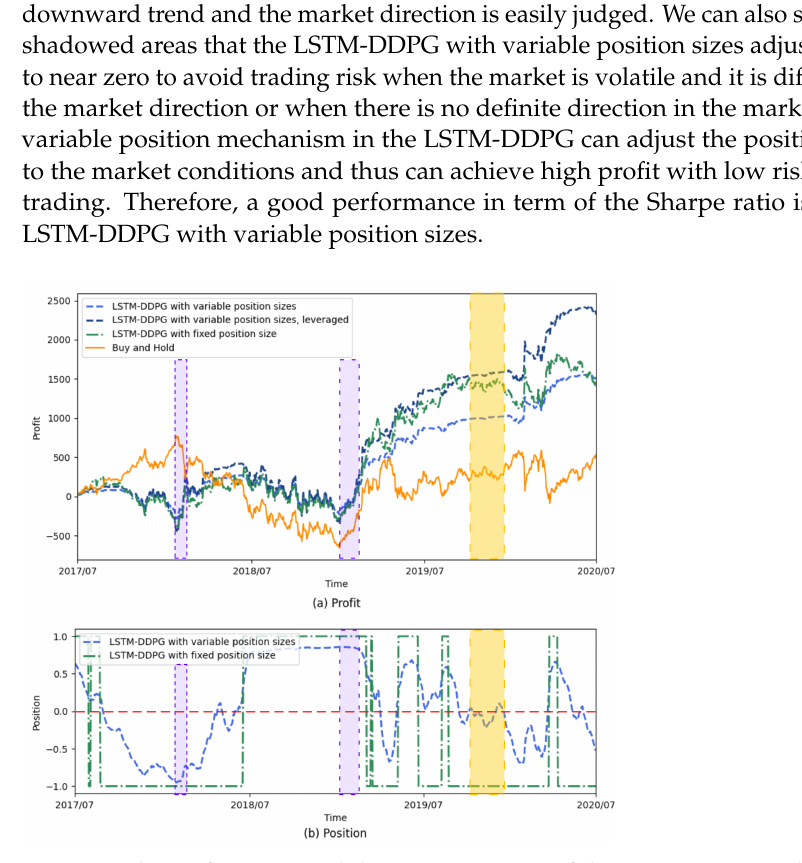
Figure 4. The profit curves and the position curves of the LSTM-DDPG with fixed and variable position